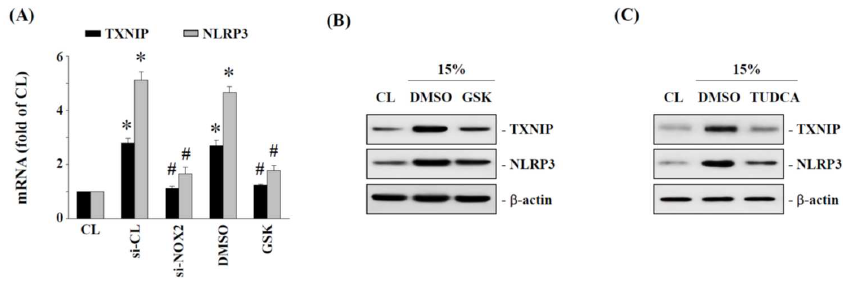
Figure 6. Inhibition of ER stress and NOX2 decreases HCS-induced TXNIP and NLRP3 expression. HAFCs were kept as CL or exposed to 15% HCS. Before being kept as CL or exposed to stretch, HAFCs were transfected with control siRNA (si-CL), or a specific siRNA of si-NOX2, or were pretreated with DMSO, or specific inhibitors for NOX2 (GSK, 20 μM) or ER stress (TUDCA) for 1 h, and then exposed to 15% HCS for 8 h. ( A ) The mRNA expressions of TXNIP and NLRP3 were determined by real-time PCR. The results are shown as mean ± SEM. ( B ) The protein expressions of TXNIP and NLRP3 were determined by Western blot analysis. Bars in ( B , C ) are the mean and SEM fold change in band density relative to control, normalized to total protein levels from three independent experiments. * p < 0.05 vs. CL. # p < 0.05 versus si-CL or DMSO-treated cells with 15% HCS stimulation.